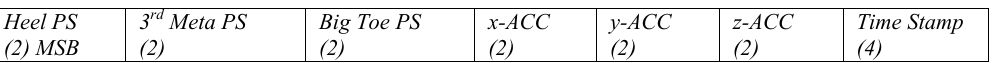
Figure 2. Notification packet when the gyroscope is not used. PS, pressure sensor;